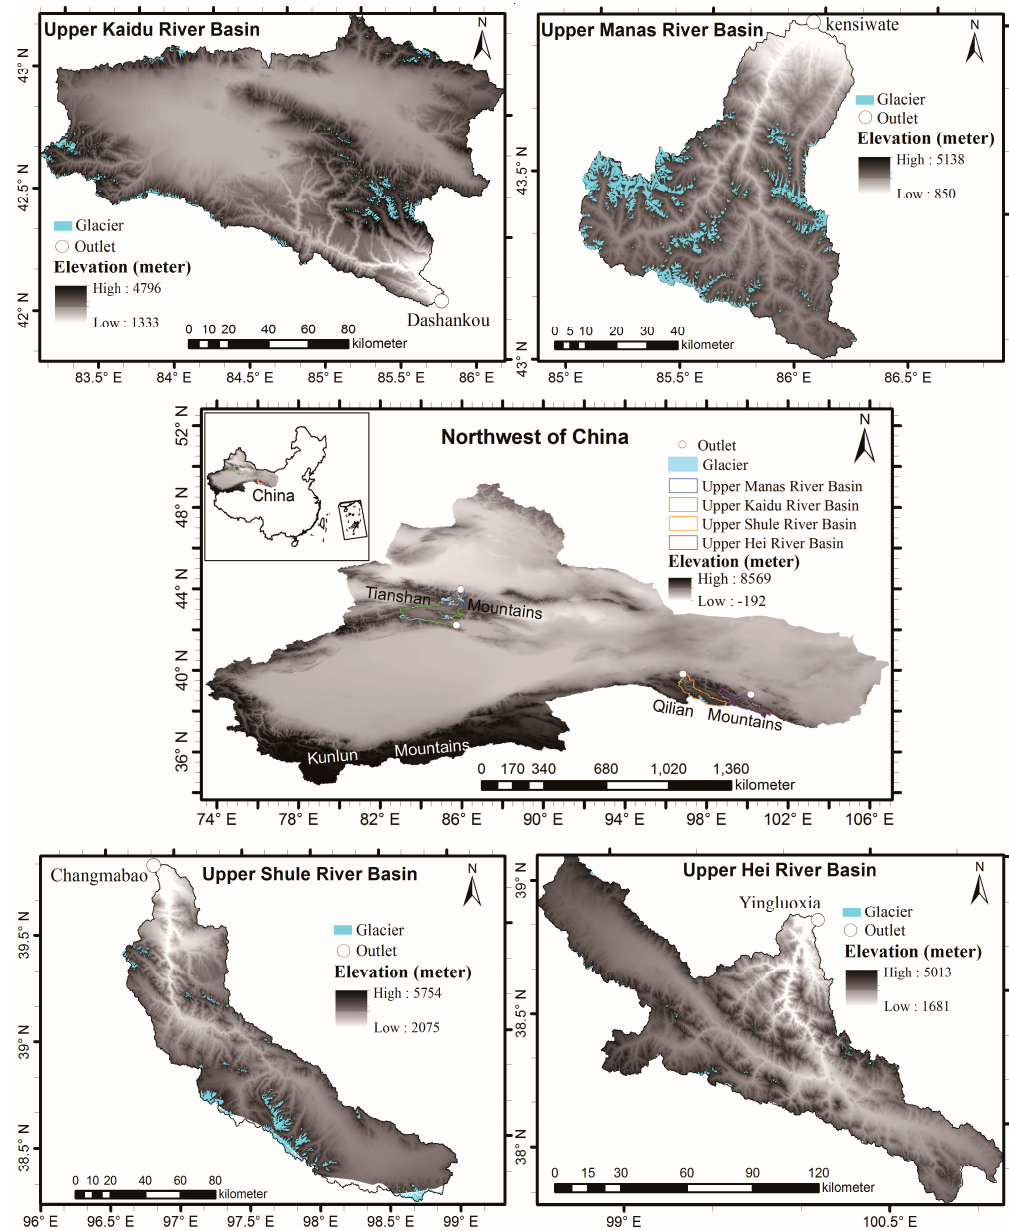
Figure 1. Locations, delineations, and glacier distribution maps of the upper basins of Kaidu River, Manas River, Shule River, and Hei River in Northwest Arid Region, China. The glacier areas account for 0.59, 2.34, 5.01, and 13.1% of the catchment drainage areas in these upper basins, respectively.